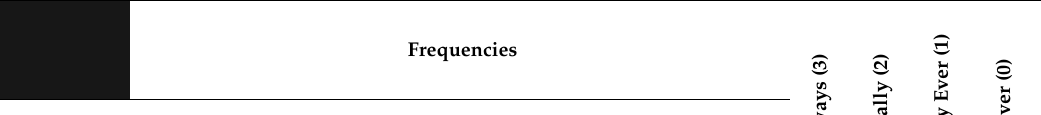
Table 4. Contingency table of the medians of each variable associated to each evaluated